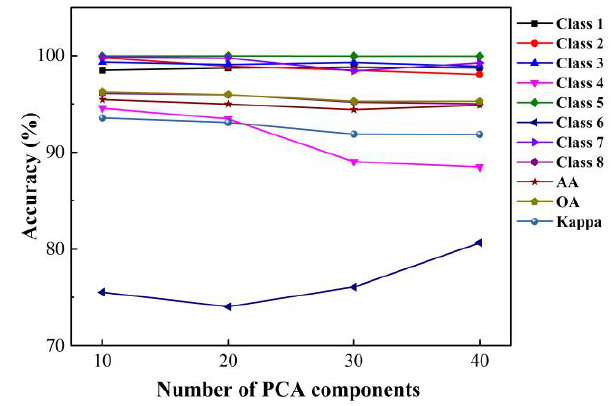
Figure 13. Classification results with different number of Principle Component Analysis method (PCA) components.